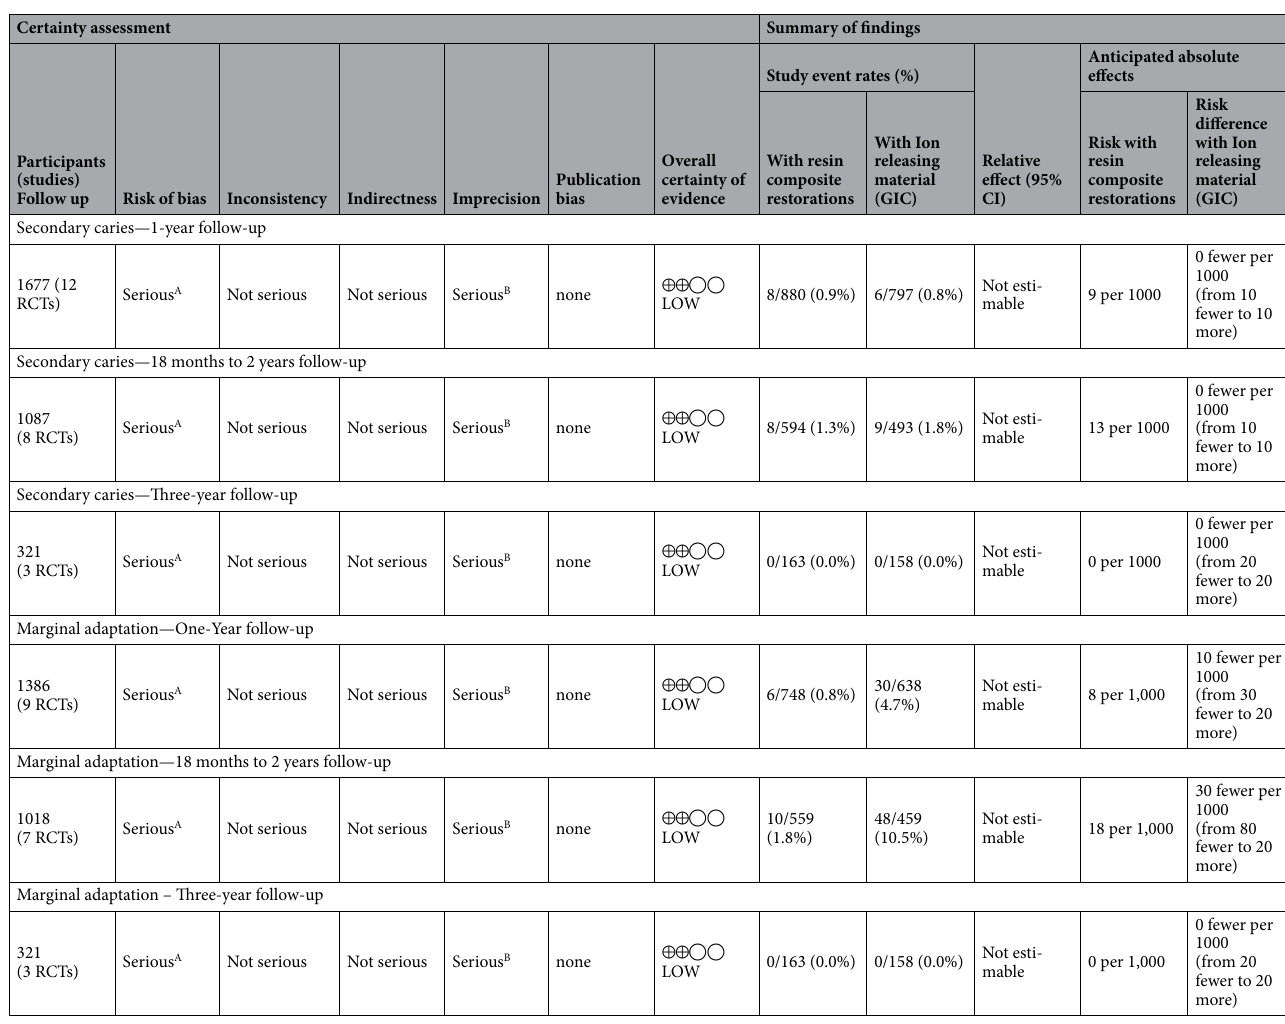
Table 2. Quality assessment of the included studies according to the GRADE tool. CI: Confidence interval. A: most of the information is from studies with an unclear or high risk of bias. B: Control and intervention arms had no events. High quality: We are very confident that the true effect lies close to that of the estimate of the effect. Moderate quality: We are moderately confident in the effect estimate: The true effect is likely to be close to the estimate of the effect, but there is a possibility that it is substantially different. Low quality: Our confidence in the effect estimate is limited: The true effect may be substantially different from the estimate of the effect. Very low quality: We have very little confidence in the effect estimate: The true effect is likely to be substantially different from the estimate of